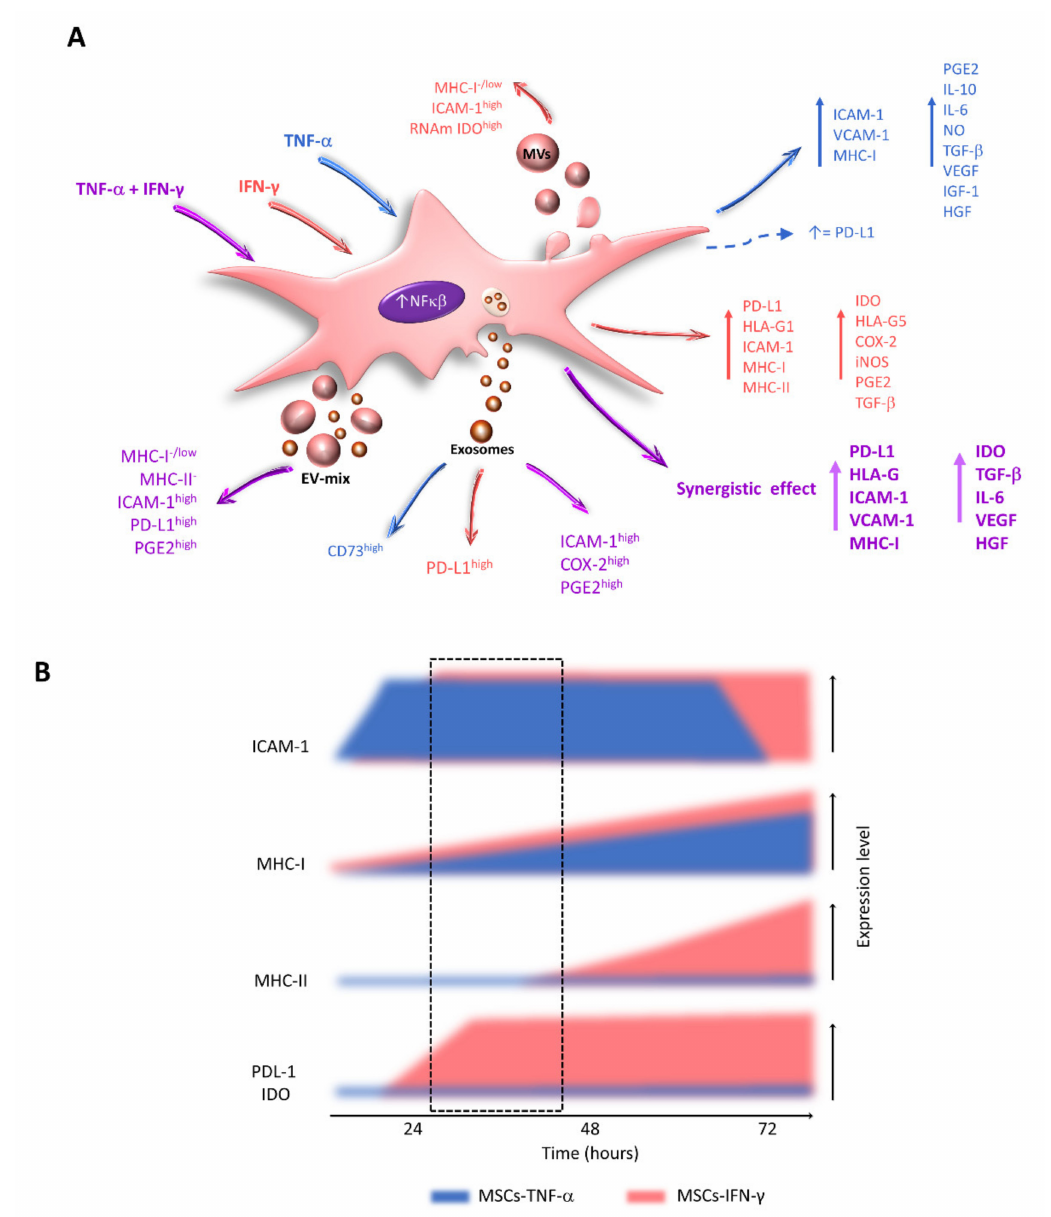
Figure 4. Effect of TNF- α and IFN- γ on the expression of immunoregulatory molecules by MSCs. ( A ) Changes in the expression of immunoregulatory molecules observed in MSCs stimulated with TNF- α (blue), IFN- γ (red), or TNF- α and IFN- γ (purple) are indicated. The changes in exosome load, MVs, and EV-mix released by MSCs treated with the indicated cytokines are also shown. ( B ) Temporal effect of TNF- α and IFN- γ on the expression of immunoregulatory and immunogenic molecules by MSCs. Between 24 and 48 h of treatment with TNF- α , MSCs increase the expression of ICAM-1 but not MHC-I and MHC-II. Simultaneously, IFN- γ stimulates the expression of ICAM-1, PD-L1, and IDO but not MHC-II. These events generate a window in which MSCs with high immunoregulatory capacity and low immunogenic potential can be obtained (dotted-line